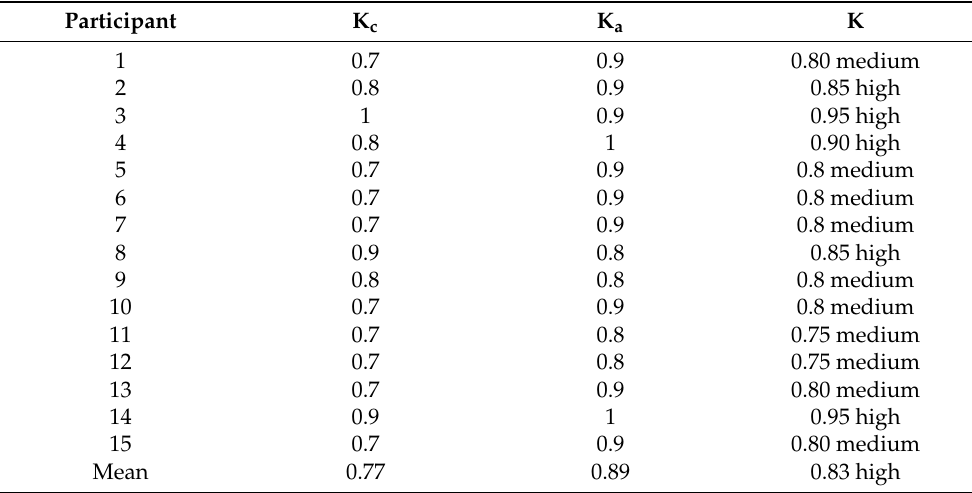
Table 3. Values obtained in each of the